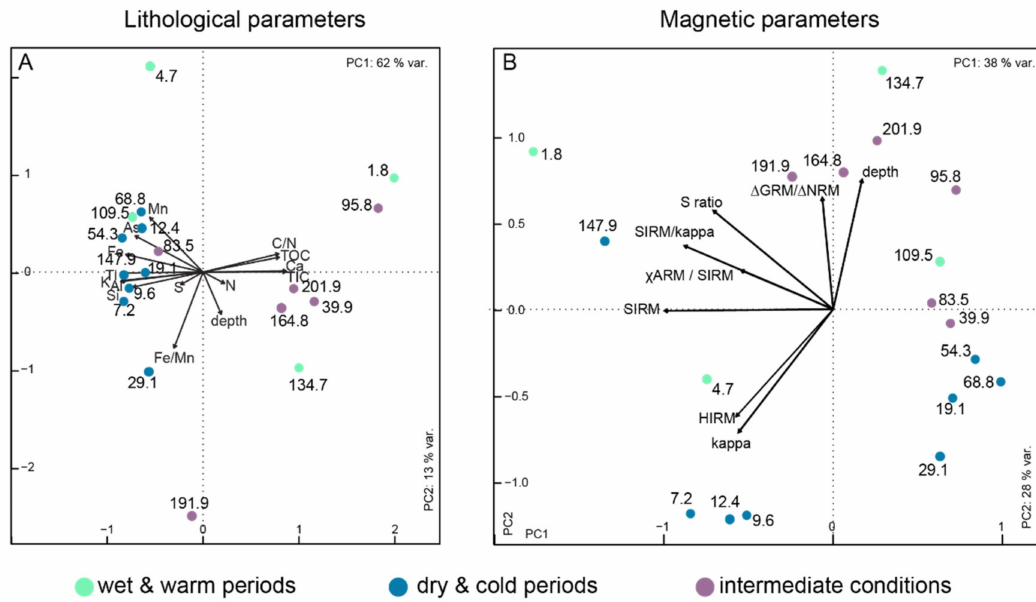
Figure 3. Principal component analysis of elemental composition of the core ( A ) and magnetic properties ( B ) along the core. Numbers correspond to sample depth (in m), and color code for wet and warm periods, mainly corresponding to interglacials (green), dry and cold periods generally corresponding to glacial stages (blue), and intermediate conditions for transitional climatic stages (purple), based on data by [1,2,8,11]. HIRM hard isothermal remanent magnetization; SIRM soft isothermal remanent magnetism; ARM anhysteretic remanent magnetization; NRM natural remanent magnetization; GRM gyro remanent magnetization; kappa magnetic susceptibility; S ratio: proportion of high to low-coercivity magnetic minerals, see Just et al., 2016 for more